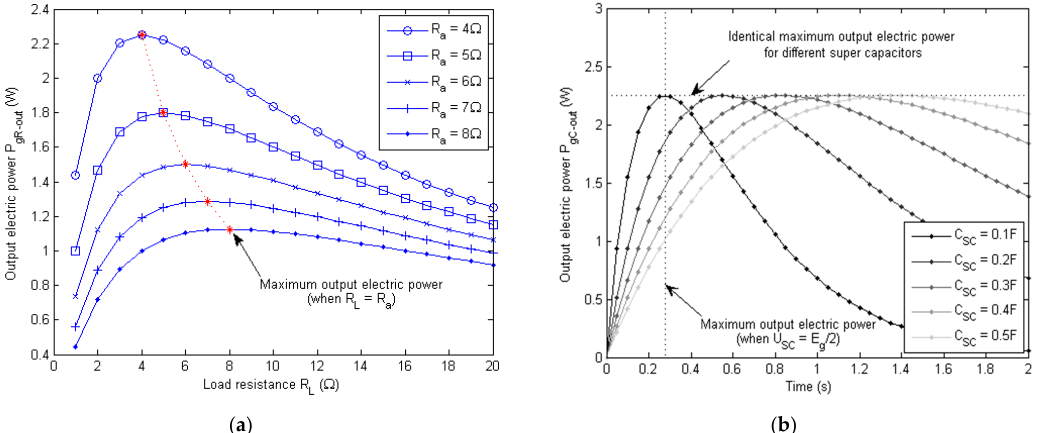
Figure 7. Simulated output electric power of the exoskeleton generator (when E g = 6 V) for resistance load and capacitance load. ( a ) Output electric power for generators with different internal resistance and load resistors. ( b ) Time history of the output electric power (when 𝑅 (cid:3028) = 4 Ω ) for different values of capacitance of the super capacitor.